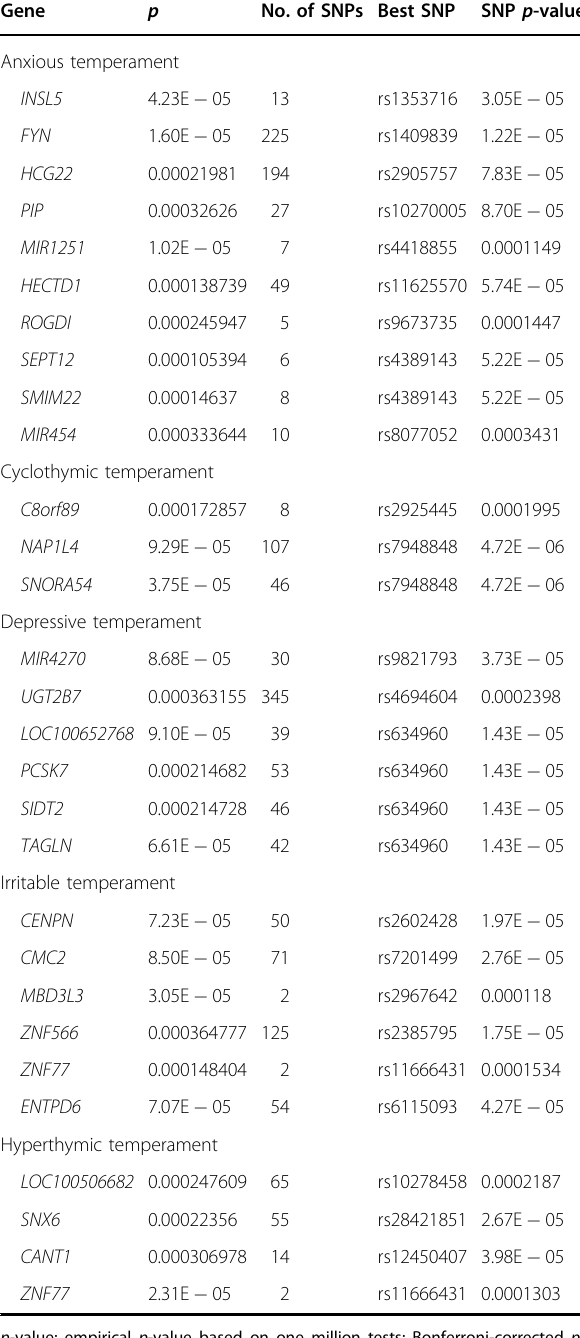
Table 2 Genes with genome-wide suggestive signi fi cance and most signi fi cant SNPs for the fi ve affective